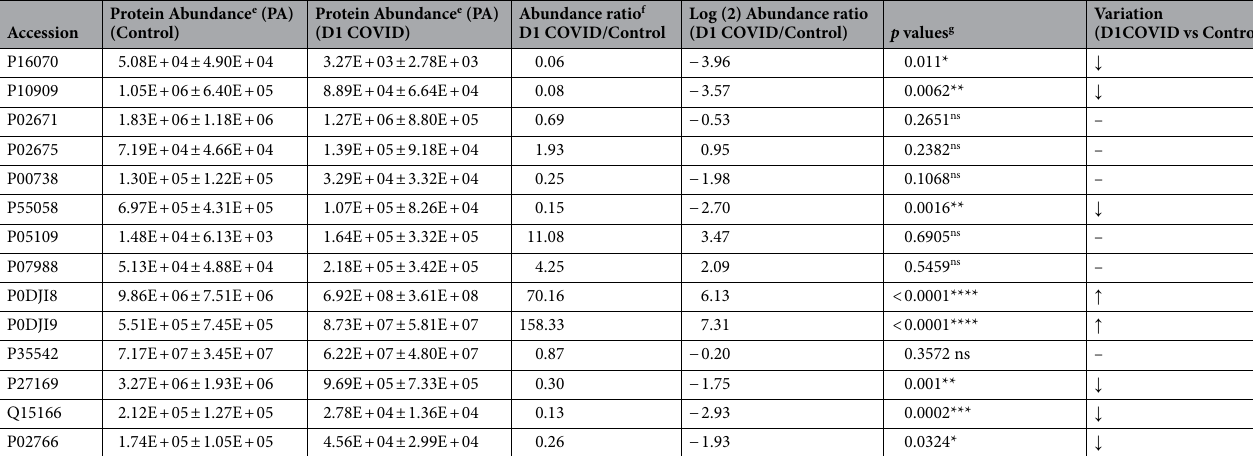
Table 3. List of proteins identified in D1 COVID-19+ and control HDL samples. HDL were isolated from the plasma of 15 control and 8 D1 COVID-19 subjects by ultrancentrifugation. MS/MS spectra were searched against Uniprot Human database, using the Sequest HT search engine. All protein identification and quantification was performed with q- values ≤ 0.01, unique peptides ≥ 2 and a Xcorr ≥ 2. For protein with unique peptide below two, MS/MS spectrum was manually inspected. a PSM’s is the total number of identified peptide spectra matched for protein. b Unique peptide to a protein identified from all samples in the analysis. c % of patients for whom this protein has been identified at Day 1. d Q peptide is the number of peptide used for the quantification. e Protein abundance is the mean of total peptide intensities for each group. f Abundance ratio is the ratio of the D1 COVID and Control protein abundances. g p values were obtained by Mann–Whitney